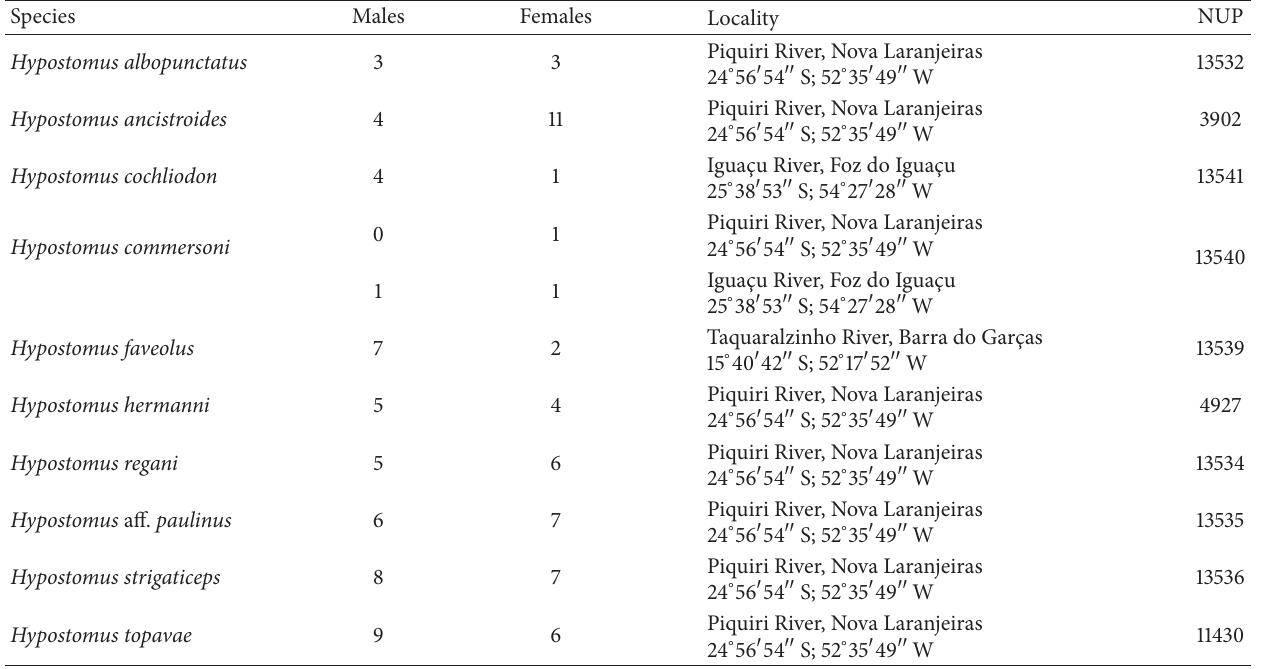
Table 1: Species, collection sites, and number of analyzed specimens and catalog numbers (NUP) of the specimens deposited in the ichthyological collection of the N´ucleo de Pesquisas em Limnologia, Ictiologia e Aquicultura. Species